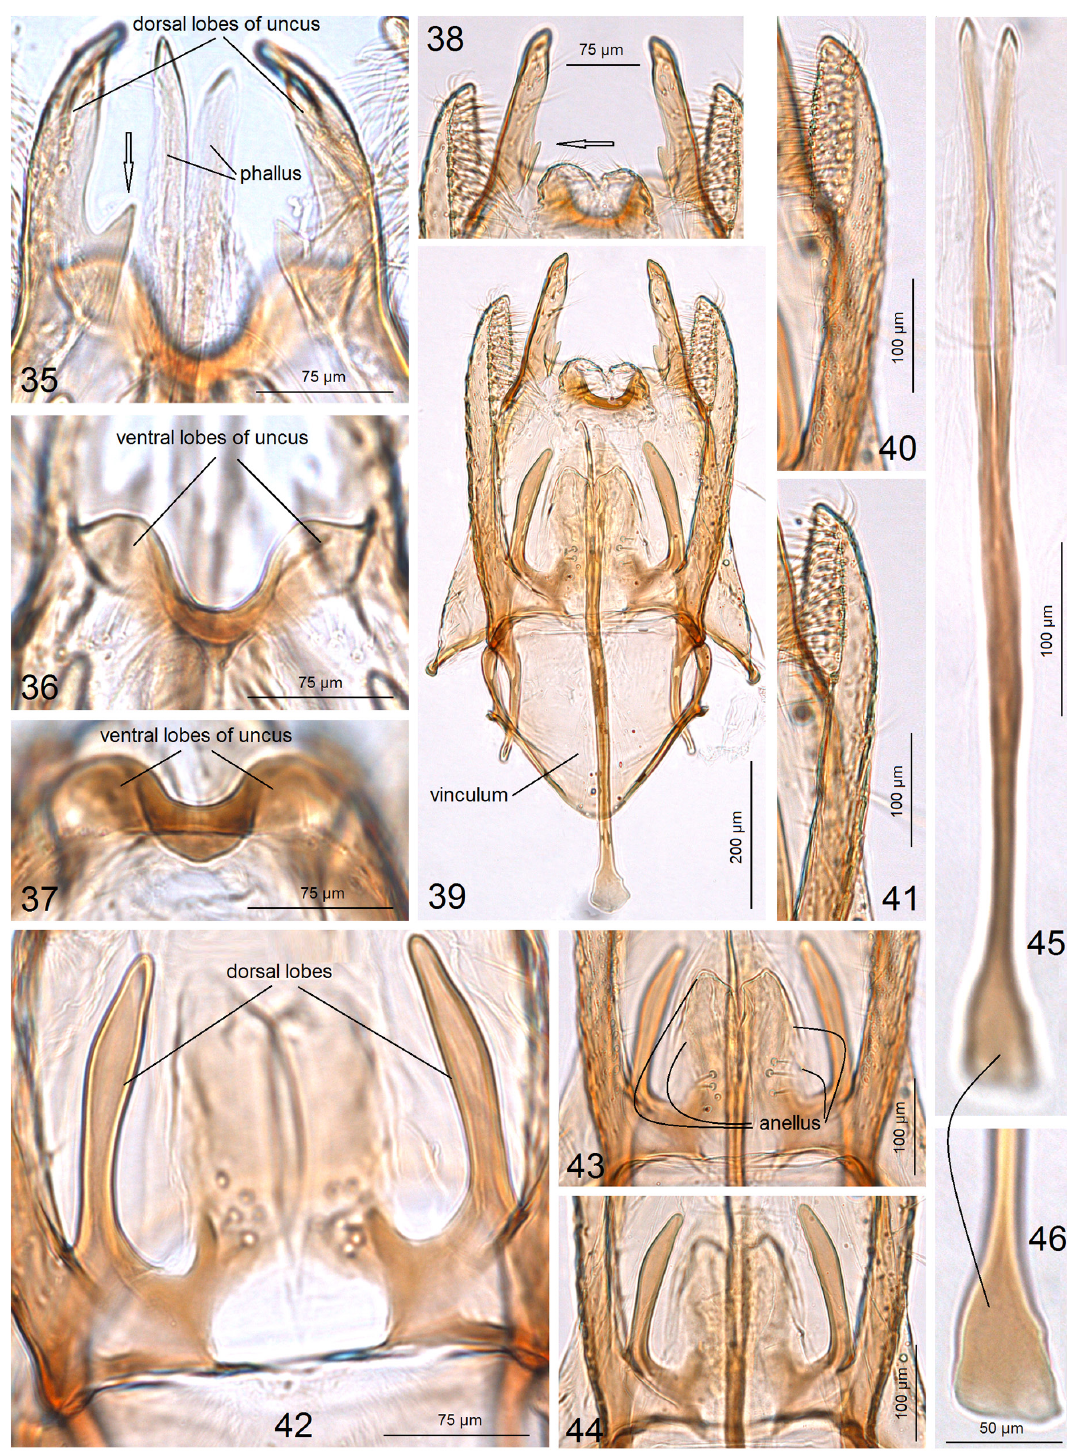
Figs 35–46. Male genitalia of Astrotischeria papilloma Diškus & Stonis sp. nov. (NHMUK). 35–36 . Dorsal and ventral lobes of uncus, paratype (genitalia slide no. 010316184). 37 . Ventral lobes of uncus, paratype (genitalia slide no. 010316185). 38 . Dorsal lobes of uncus, holotype (genitalia slide no. 010316182). 39 . General view, uncus, holotype (genitalia slide no. 010316182). 40–41 . Same, valva. 42 . Dorsal lobe of valva, paratype (genitalia slide no. 010316185). 43–44 . Anellus and dorsal lobe of valva, holotype (genitalia slide no. 010316182). 45–46 . Phallus, paratype (genitalia slide no.